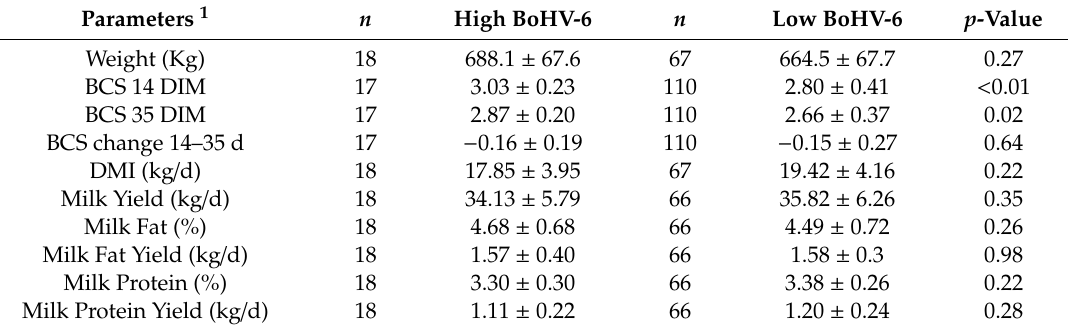
Table 2. Body weight, body condition score, dry matter intake, and milk production measurements (mean ± SD) of cows with high ( > 200) and low (1–200) BoHV-6 scores over the first 50 days in milk. Parameters 1 n